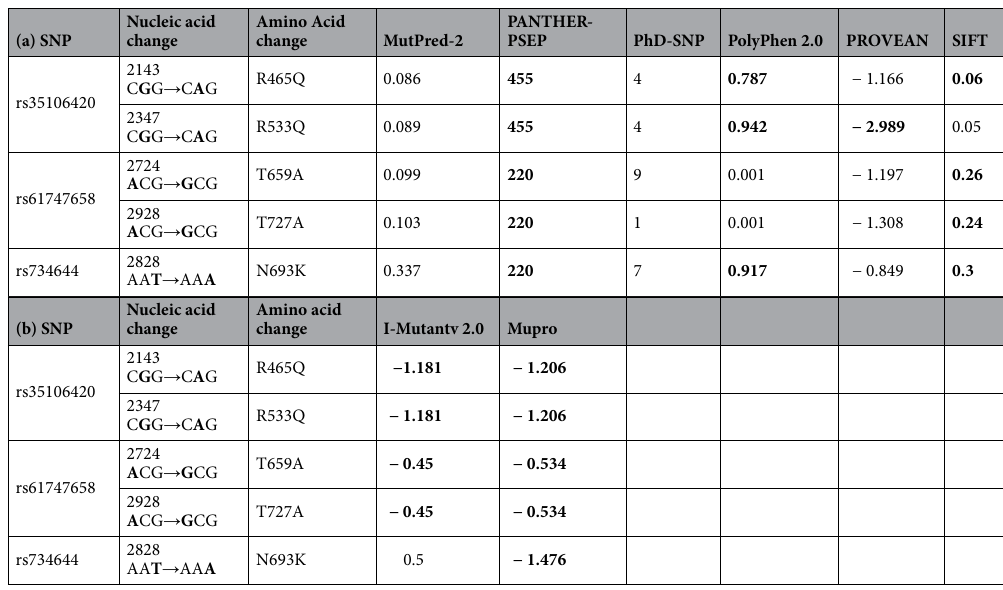
Table 2.. ( a ) Pathogenicity scores for ADGLR3 nsSNPs using different in-silico tools. Scores highlighted in bold indicate that variants are likely to be pathogenic, (b) Prediction of protein folding free energy changes using I-Mutantv 2.0 and Mupro, Scores highlighted in bold suggest that amino acid changes affect protein stability.